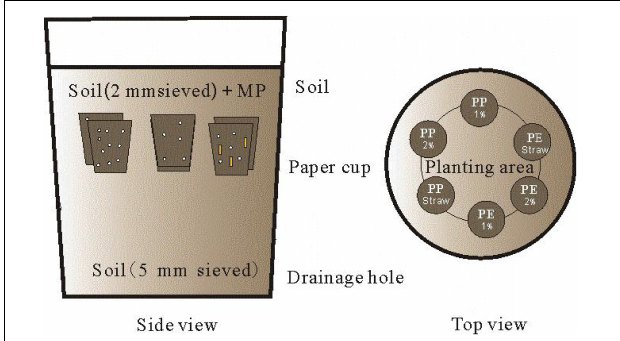
FIGURE 1 | The side view and top view of the incubation device were designed. Microplastics and maize straw were added into paper cups and then buried at 20 cm soil depth in the bucket for incubation. The soil outside the paper cup should be sieved 5 mm to distinguish it clearly from the soil inside the paper